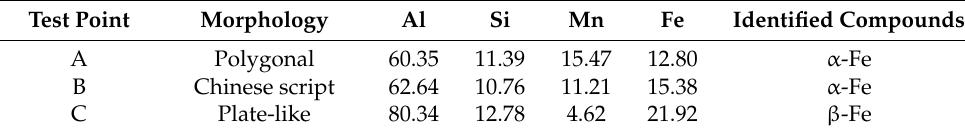
Table 2. Chemical composition of Fe-rich phase in alloy (wt.%).